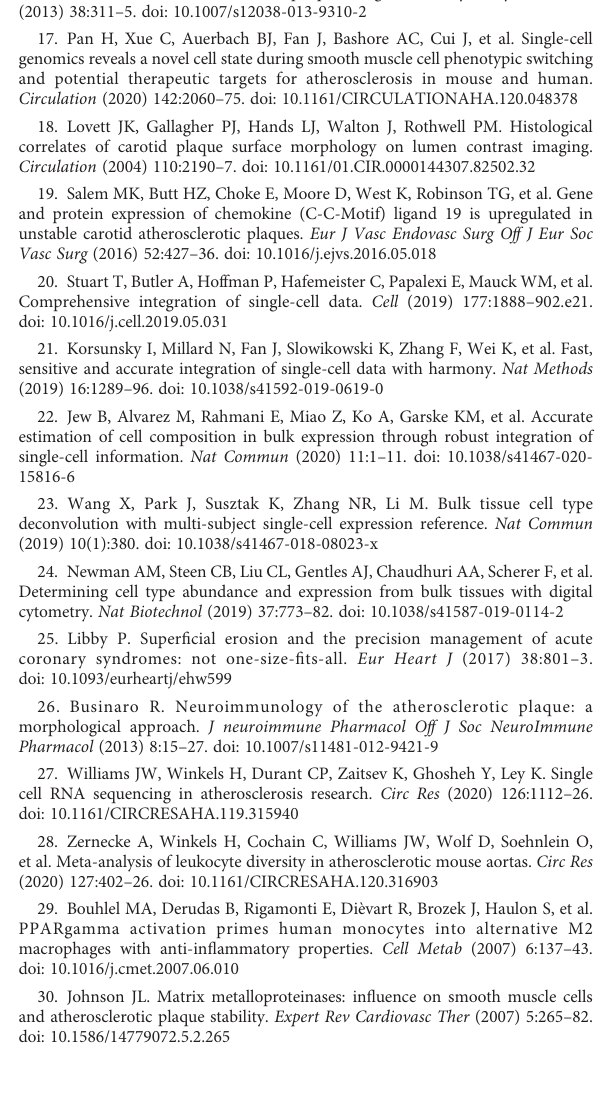
SUPPLEMENTARY FIGURE 1 Dataprocessing. (A,B) Boxplotandprincipalcomponentanalysis(PCA)of expression pro fi le across selected dataset before batch effect correction. (C, D) Box plot and principal component analyses of expression pro fi le after batch effect correction. SUPPLEMENTARY FIGURE 2 Immune in fi ltration in individual dataset. Identifying the signi fi cantly SUPPLEMENTARY FIGURE 3 GO and KEGG pathway enrichment analysis of the DEGs between unstable and stable plaques. (A) Dot plot of enriched GO termed for DEGs. (B) Dot plot of enriched KEGG pathway for DEGs.